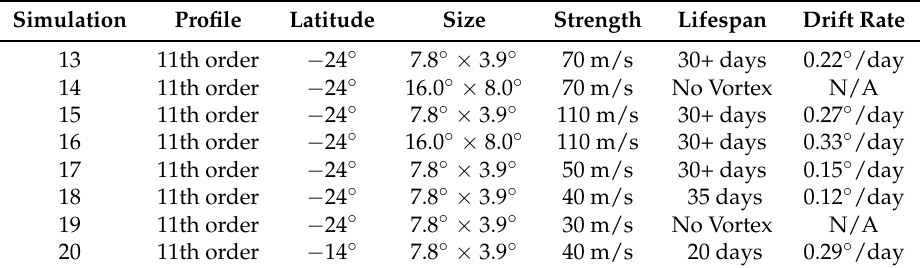
Table 3. Results of additional dry simulations.